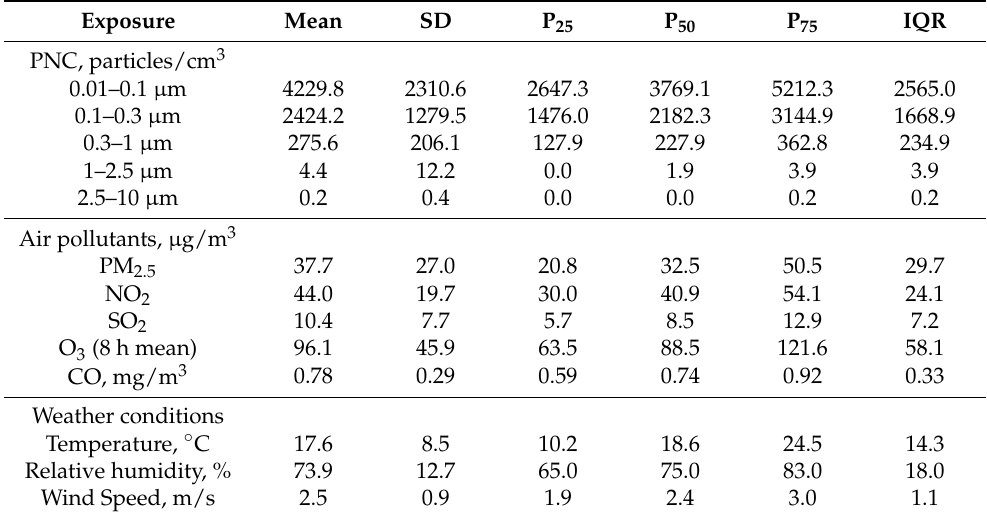
Table 2. Summary statistics of air pollution levels and weather conditions on the current day of clinic visits during study